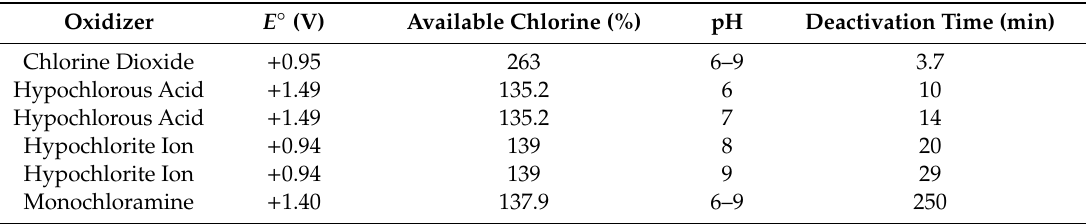
Table 4. Comparison of various chlorine-based oxidizers showing standard reduction potential, available chlorine, and deactivation time for 1-log reduction of Giardia cysts at 25 ◦ C. Adapted from